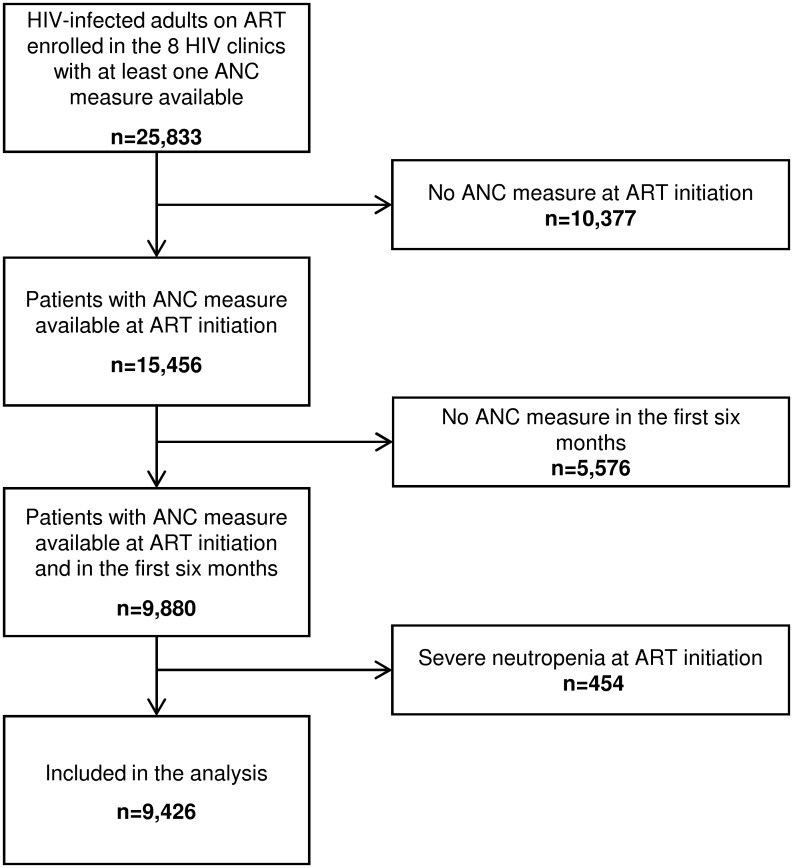
Study population flow chart.ANC, absolute neutrophil count; ART, antiretroviral therapy.